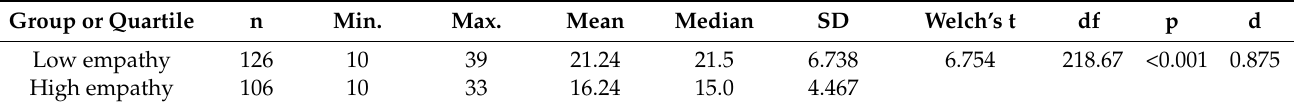
Table 8. Comparison between high- and low-empathy groups by their moral disengagement means. Group or Quartile n Min. Max. Low empathy High